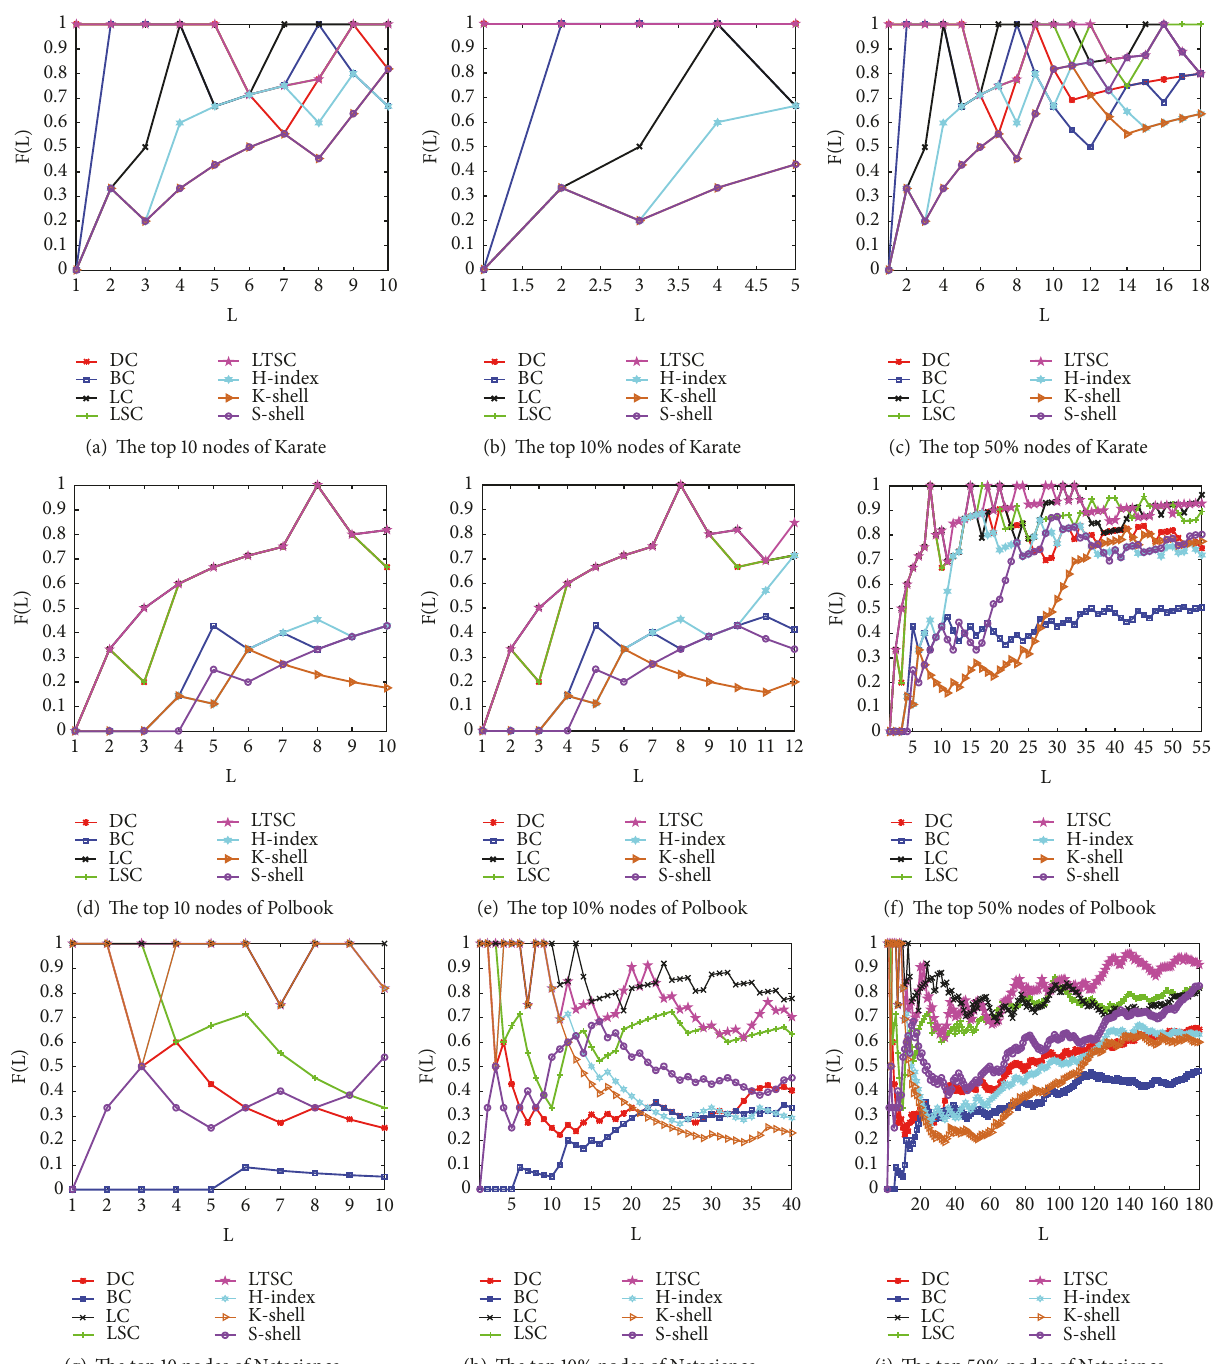
Figure 4: The ranking similarity 𝐹(𝐿) for the top 𝐿 nodes of ranks offered by eight evaluating indexes with the SIR model on Karate, Polbook, and Netscience networks, respectively, where 𝐿 = 10, 10 % , 50